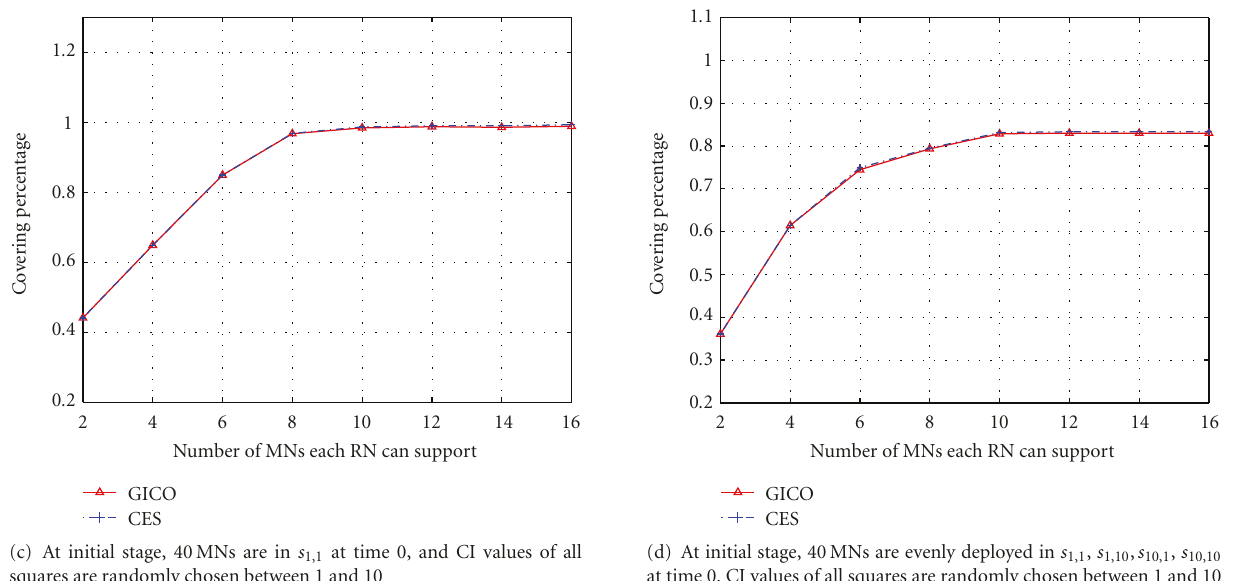
Figure 8: Average covering percentage over the entire relief process versus di ff erent capability of RNs in four scenarios. r = 1 . 5 L , M =